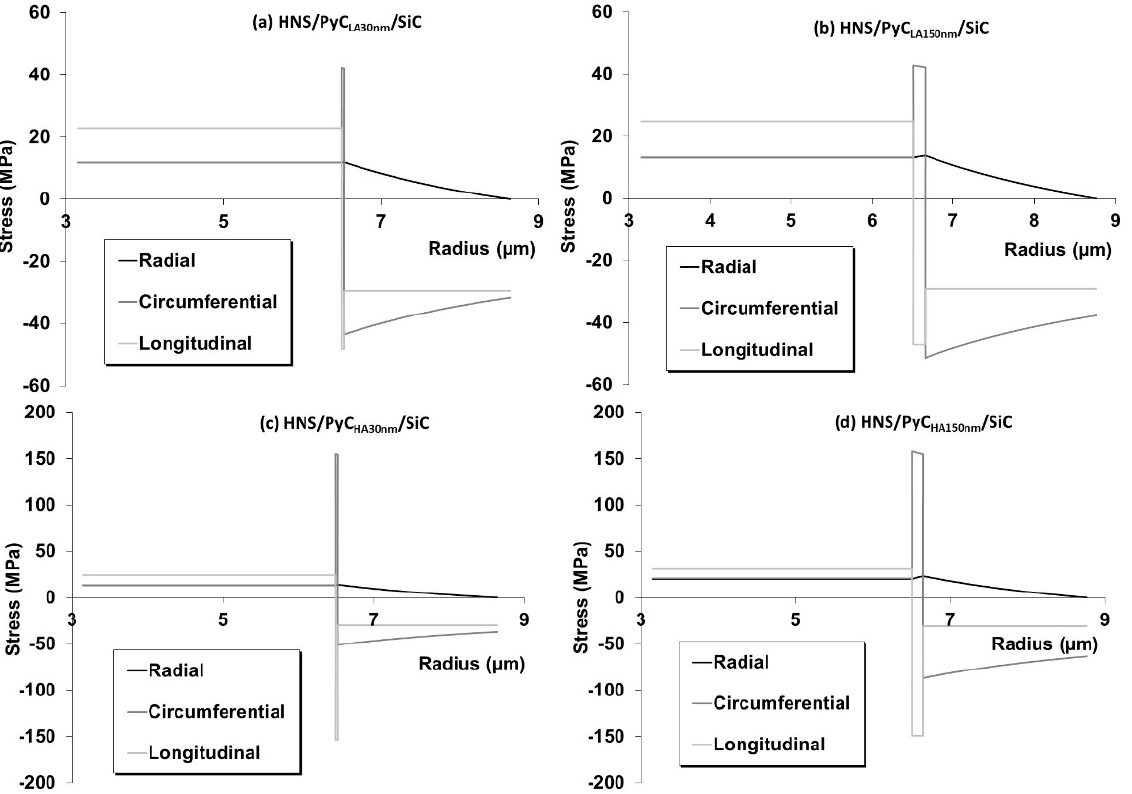
Figure 3. Radial, circumferential and longitudinal residual thermal stresses calculated in microcom- posite with fiber and matrix volume fractions as given in Table 2.